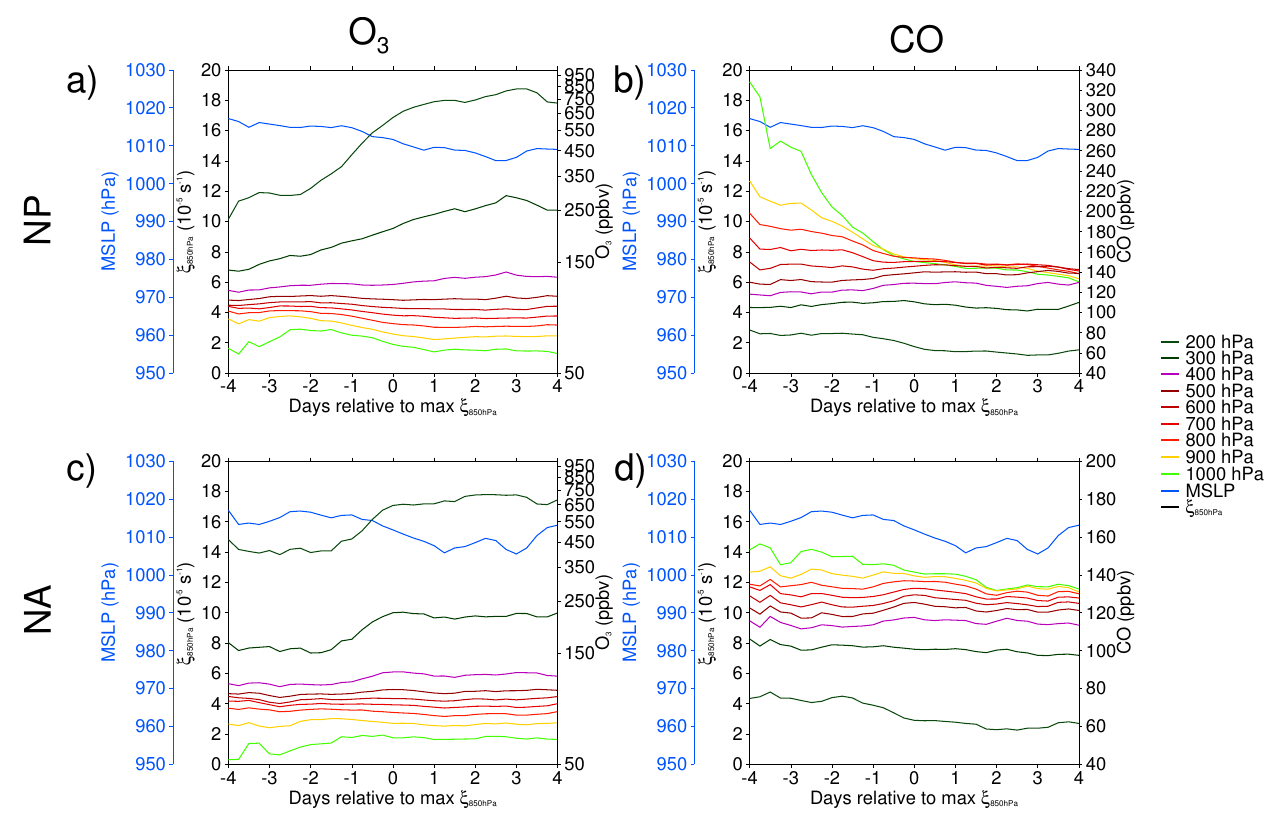
Figure 3. Same as Fig. 2 but for storm track locations with the background meteorology and chemistry.